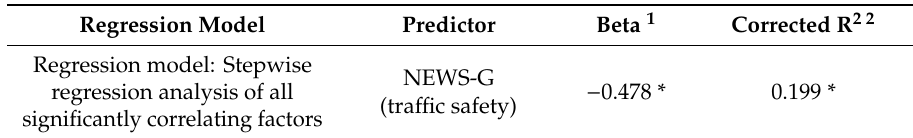
Table 6. Regression models PAQ-50 +